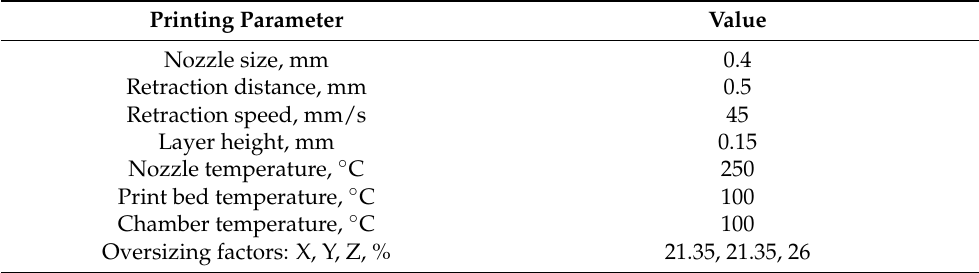
Table 2. Printing settings for the BASF Ultrafuse 316L specimens.